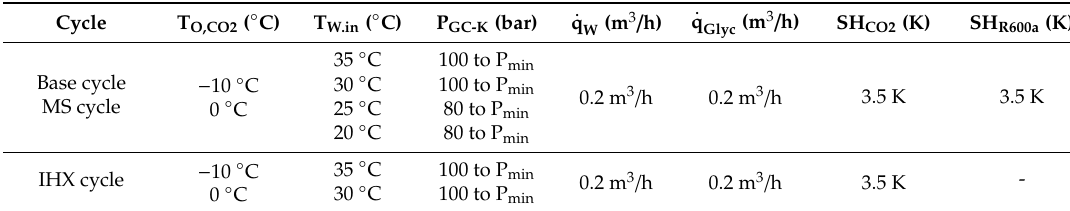
Table 3. Reference